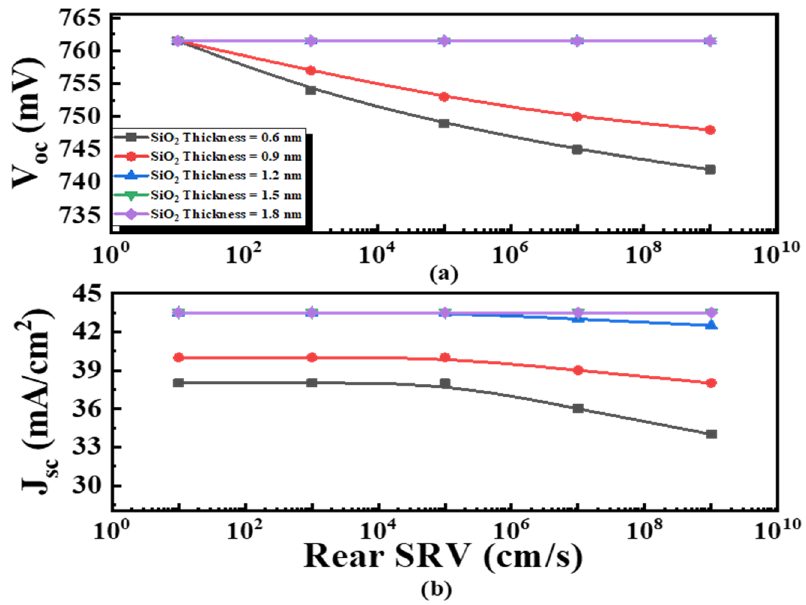
Figure 11. Effect of rear-SRV (1 × 10 1 –1 × 10 9 cm/s) with various oxide thickness (0.6–1.8 nm) on ( a ) V oc and ( b ) J sc on the TOPCon solar cell. ( a ) V oc and ( b ) J sc on the TOPCon solar